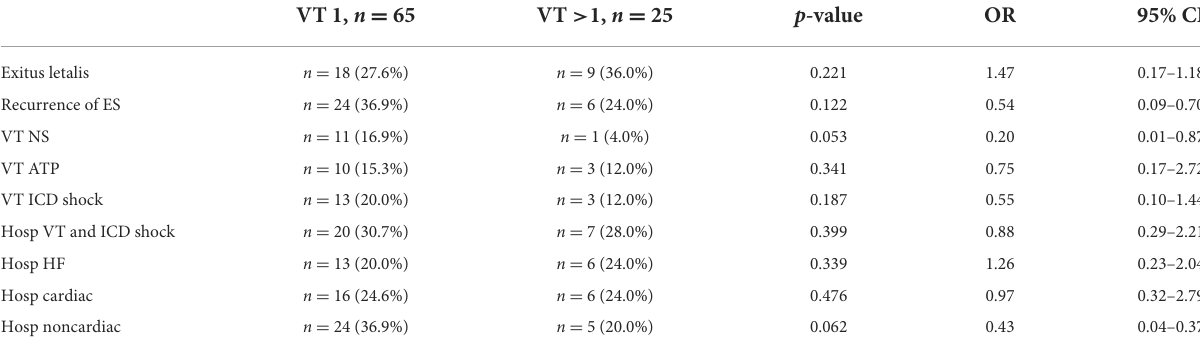
TABLE 9 Analysis between one clinical VT vs. more than one clinical VT available.